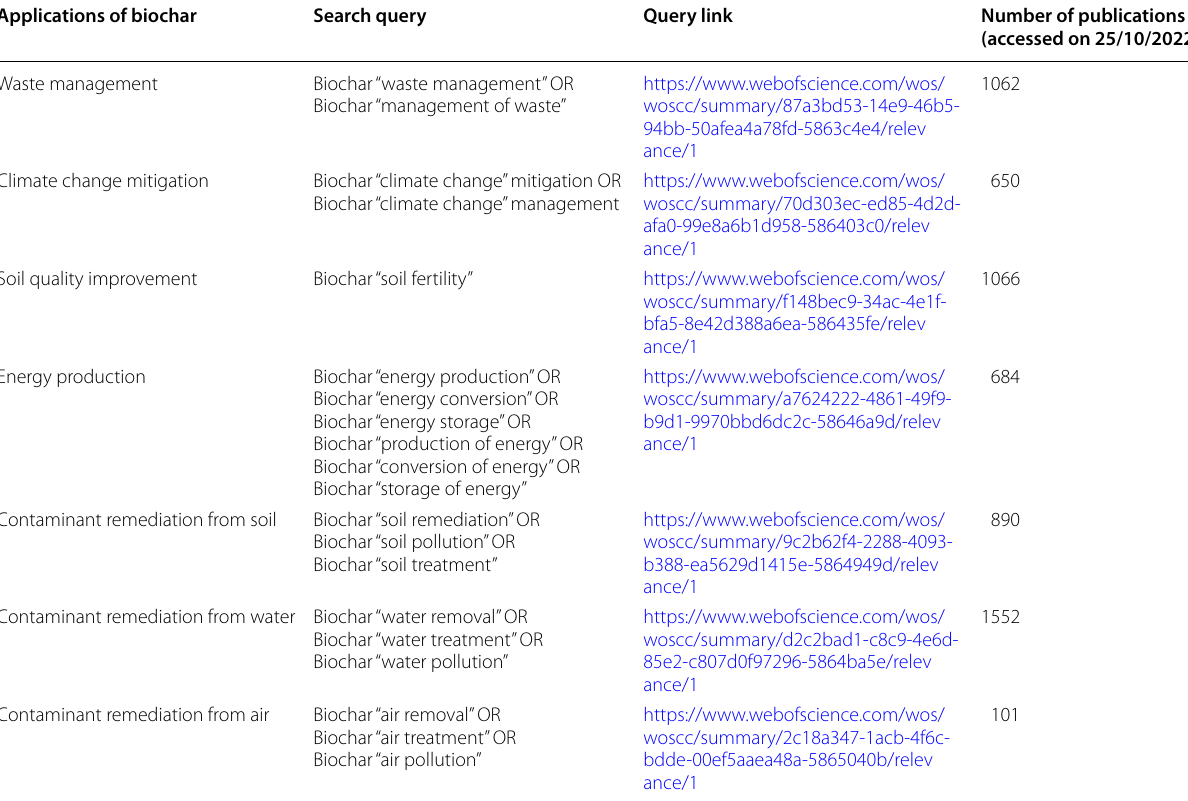
Table 1 Search queries used for identifying various publications relevant for the biochar applications Applications of